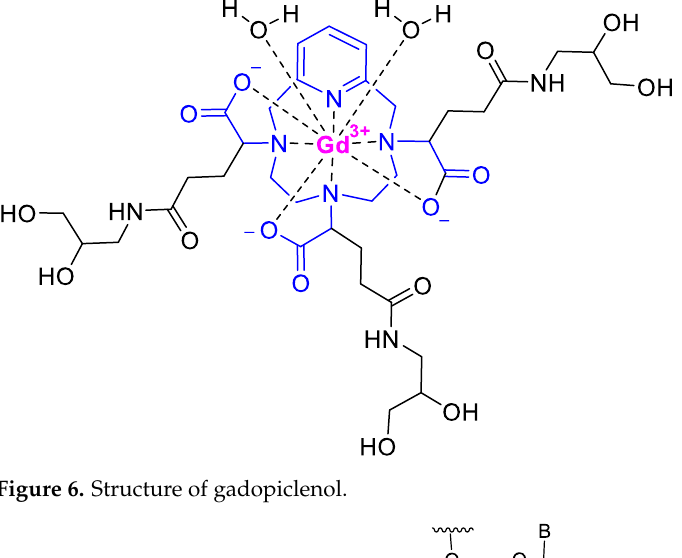
Figure 6. Structure of gadopiclenol.